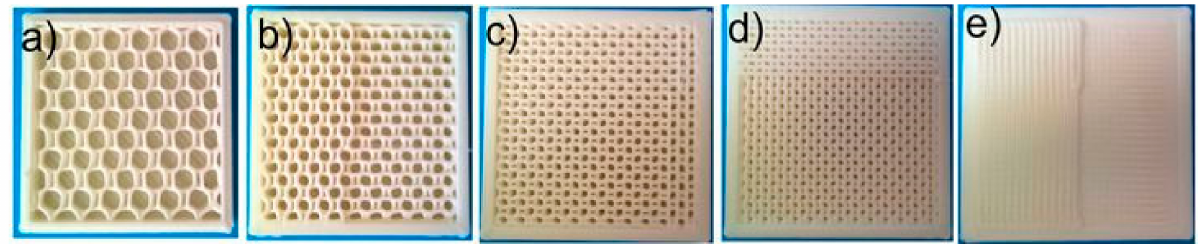
Figure 2. Photographs of printed samples with various densities of infill: ( a ) 30%, ( b ) 50%, ( c ) 70%, ( d ) 90%, ( e )